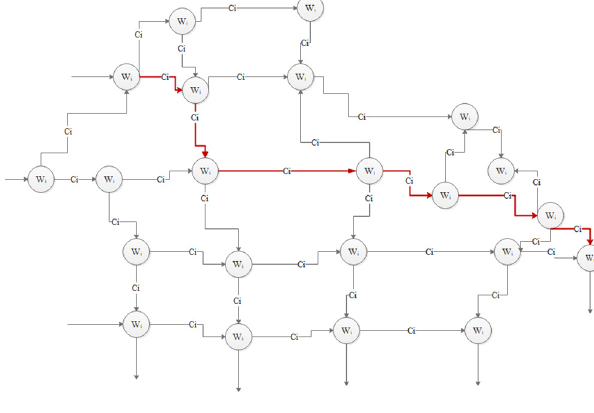
Figure 5. Pattern of vehicle model